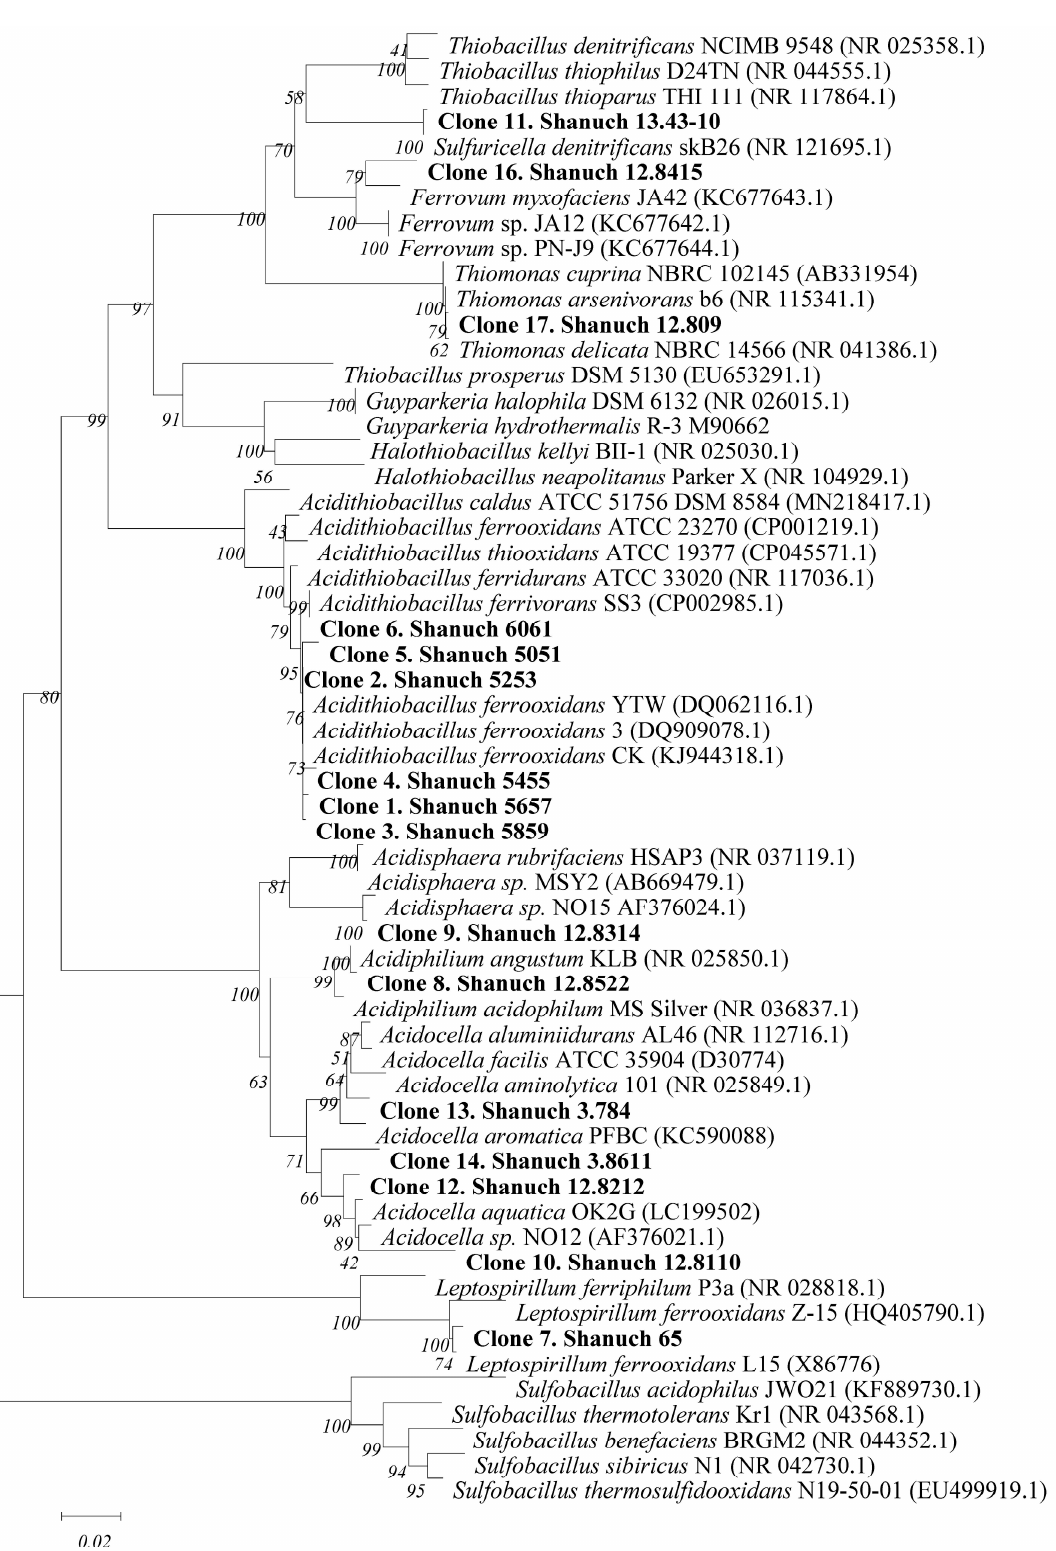
Figure 3. Unrooted phylogenetic tree based on an analysis of the 16S rRNA gene sequences of metal-leaching acidophilic bacteria dominated in the Shanuch deposit microbiota before and after cultivation [36]. The dendrogram was constructed using MEGA 6 software (neighbor-joining analysis) based on a 1536 bp aligned sequence. The sequences obtained in this work are highlighted in bold. Figure 3 is published by permission of Springer Nature Publisher (License Number